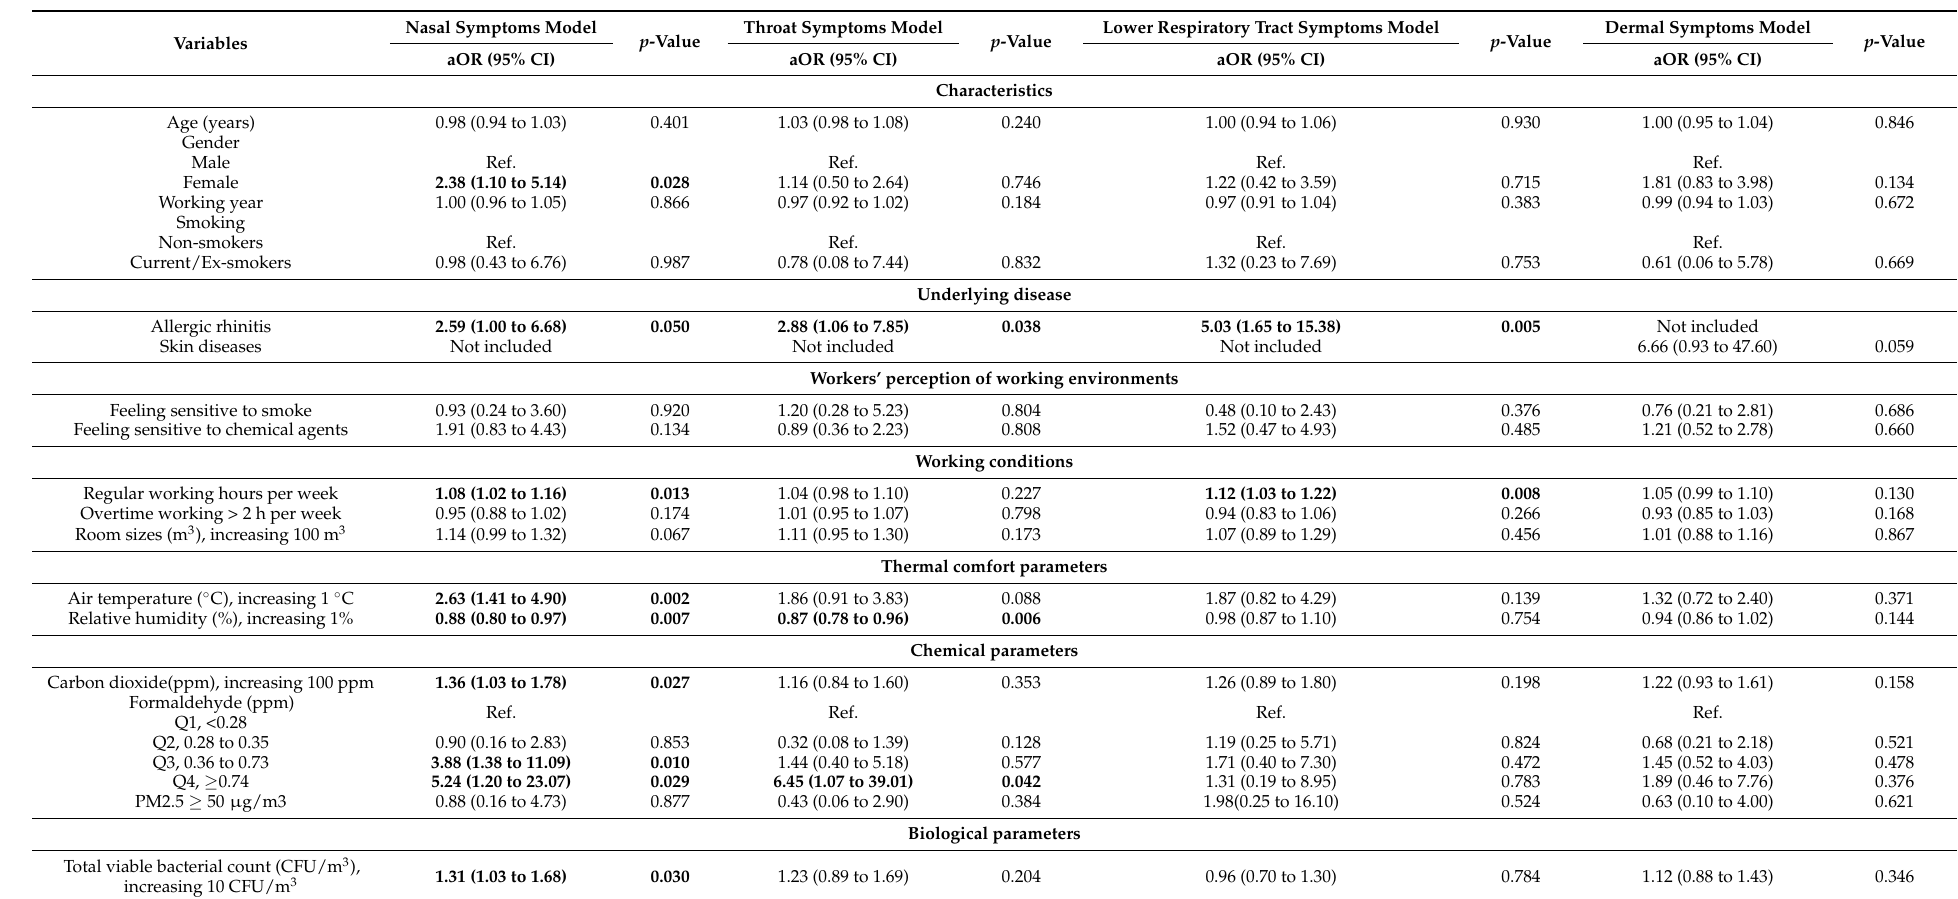
Table 3. The associated factors of SBS by a multivariable logistic regression